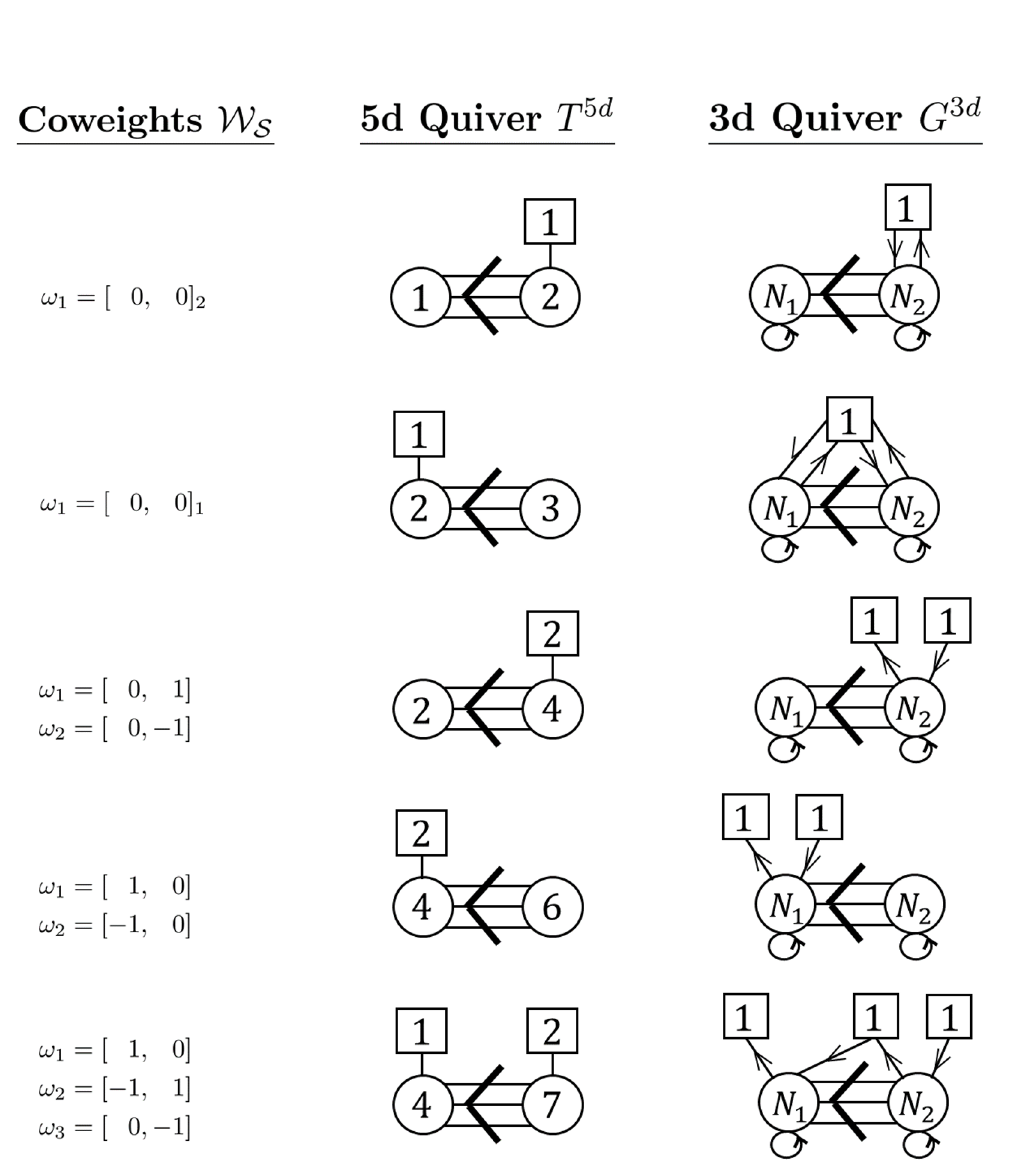
Figure 11. Distinct defects of the G 2 little